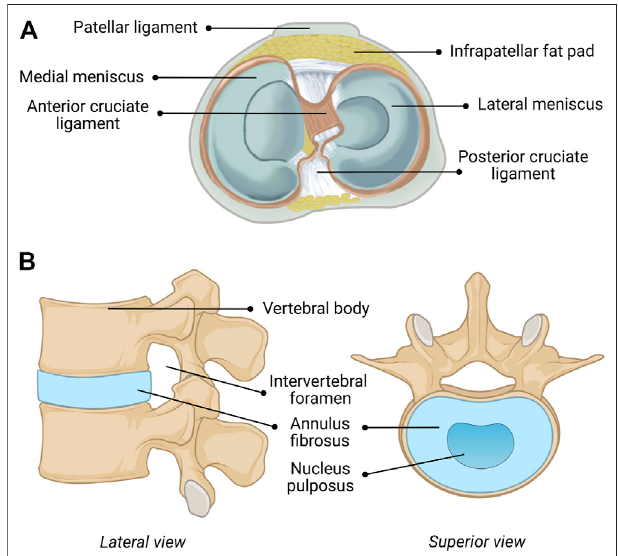
FIGURE 1 | Anatomical composition of the (A) human knee (including menisci) and (B) human intervertebral disc (IVD). Figure 1A reprinted with minor alterations from (Guo et al., 2015) under Creative Commons Public Domain Dedication waiver (creativecommons.org/publicdomain/zero/